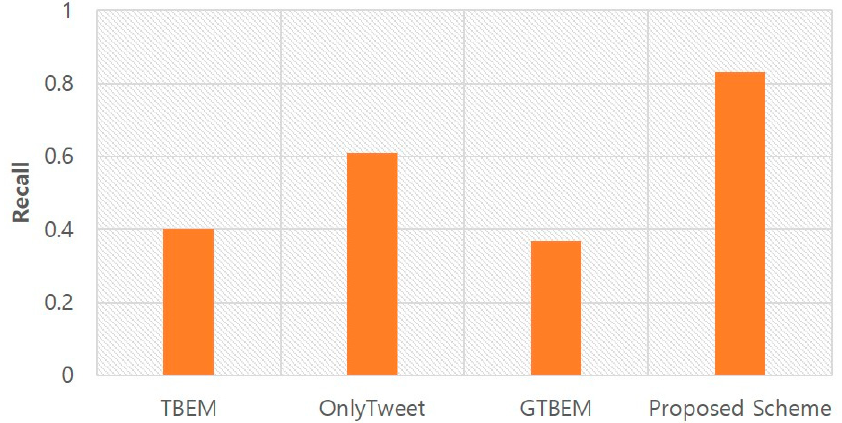
Figure 9. Comparison of recall according to the local event detection schemes.